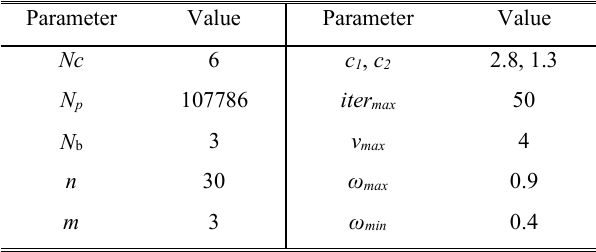
Table 1. Setting of the initial